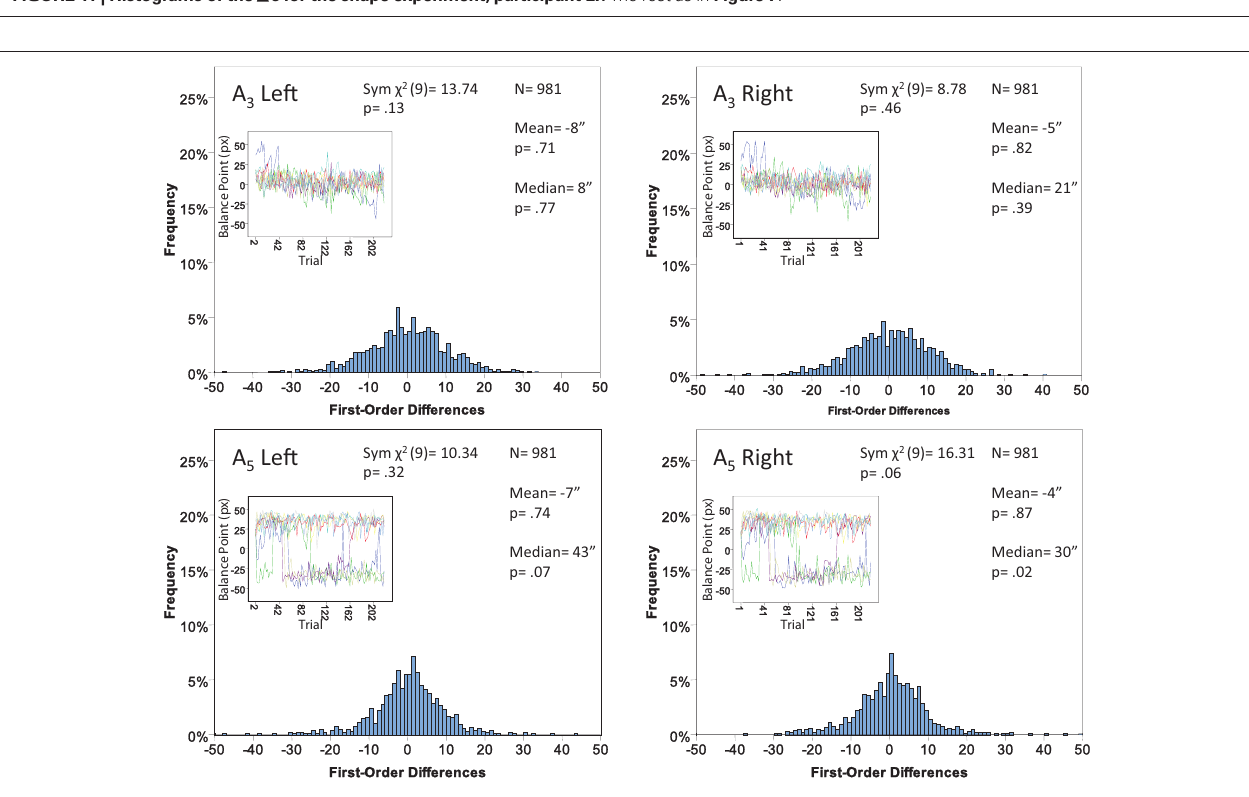
Figure 11 | Histograms of the ∆ ’s for the shape experiment, participant LP. The rest as in Figure 7 .